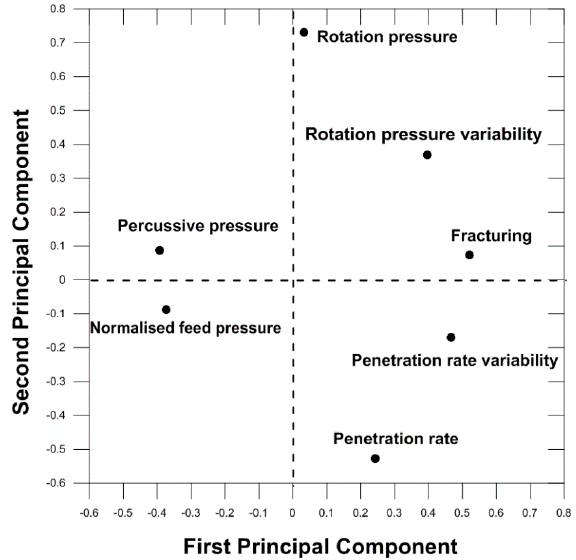
Figure 13. Loading plot of first and second principal components.